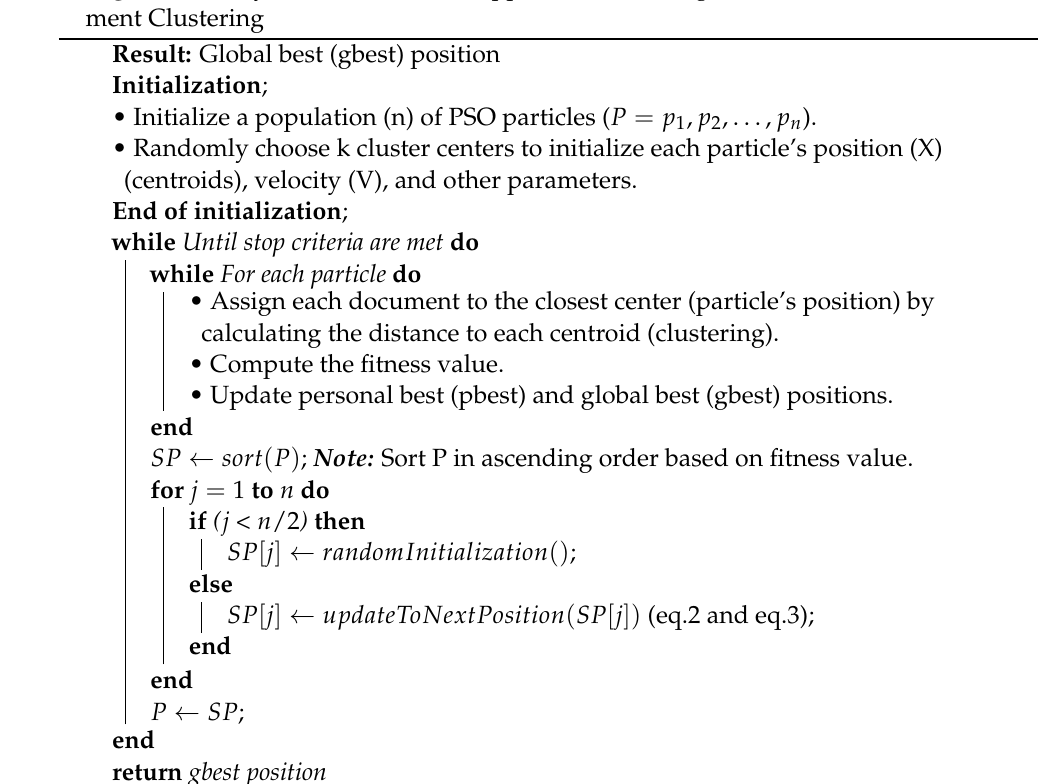
Algorithm 3: Dynamic Sub-Swarm Approach of PSO Algorithms for Text